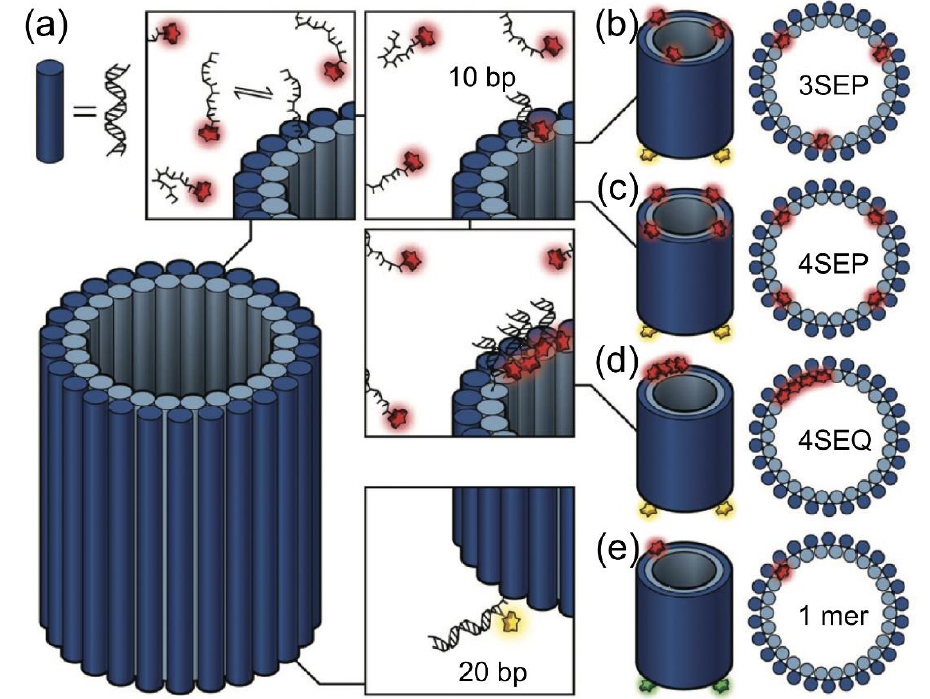
Figure 12. DNA nanotube. ( a ) 52 helix nanotube with 3′-DNA staples integrated with the DNA-PAINT docking strand (10 nt), complementary to the Alexa647-labeled imager strand. Multimeric nanotubes with ( b ) 3SEP, which have three docking sites at the top; ( c ) 4SEP, which integrates four PAINT docking sites at the top with a gap of approximately 15 nm; and ( d ) 4SEQ, which has four close docking sites separated by approximately 3 nm. Each nanotube base has four 20 nt staples, which are complementary to the oligonucleotide labeled with ATTO565 (for 3SEP, 4SEP, and 4SEQ) and Alexa488 (for 1mer). ( e ) For qPAINT calibration, a 1mer single-site nanotube is used. The images were reproduced with permission from Baker et al., published by the Royal Society of Chemistry, 2019 [53].